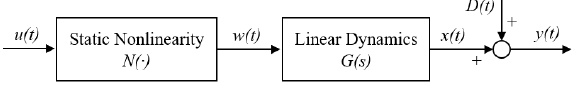
Figure 1. The framework of the Hammerstein model.